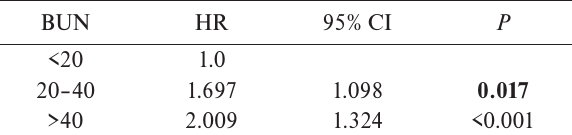
Table 6. Hazard ratios for Czech patients.